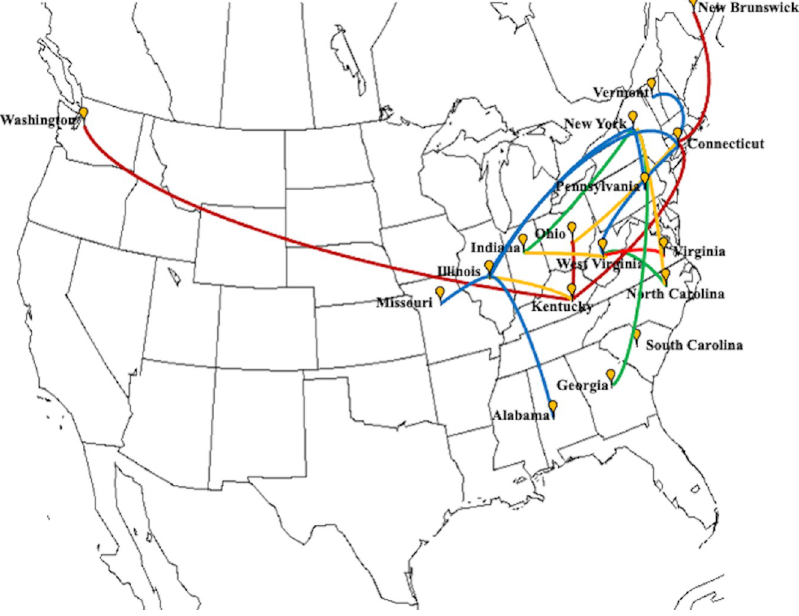
Fig 5. Map showing connections between significant location pairs with BF � 3 as determined by BSSVS analysis. Blue line color corresponds to BF = 3 to 5, yellow line corresponds to BF > 5 to 10, green line corresponds to BF > 10 to 20, and the red line corresponds to BF >